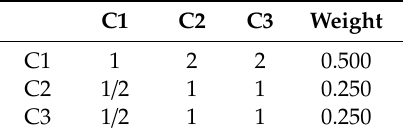
Table A10. Pairwise comparison matrix of rural capacity indicators.